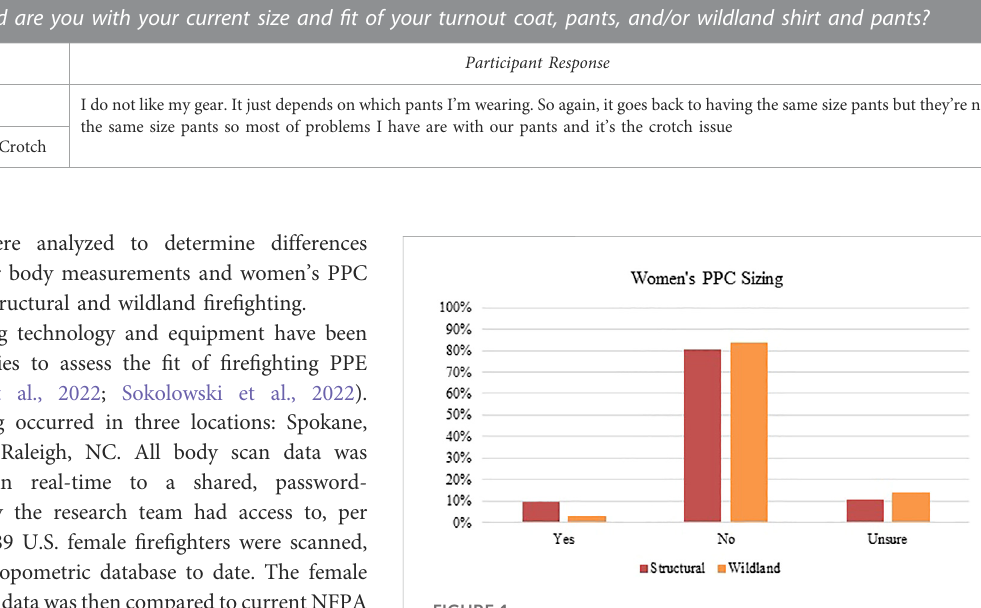
FIGURE 1 Percentage of female structural and wildland fi re fi ghters with women ’ s sized